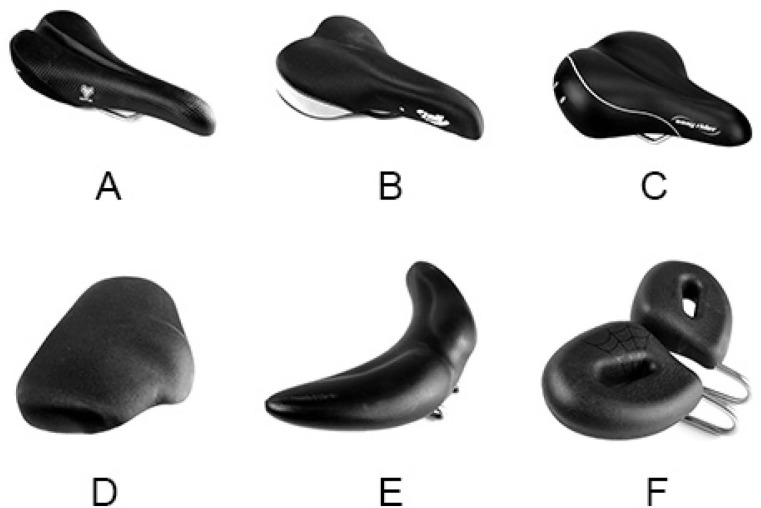
Test seats models.